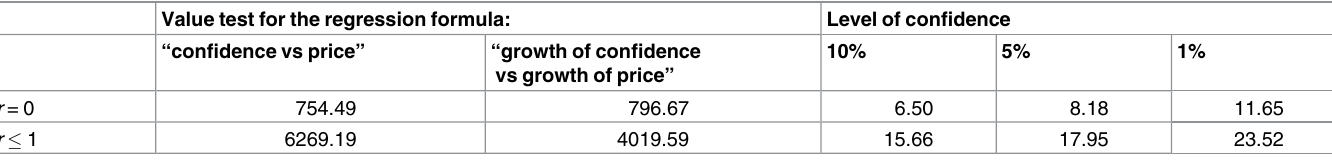
Table 4. Johansen test for confidence x stock price. Value test for the regression formula: